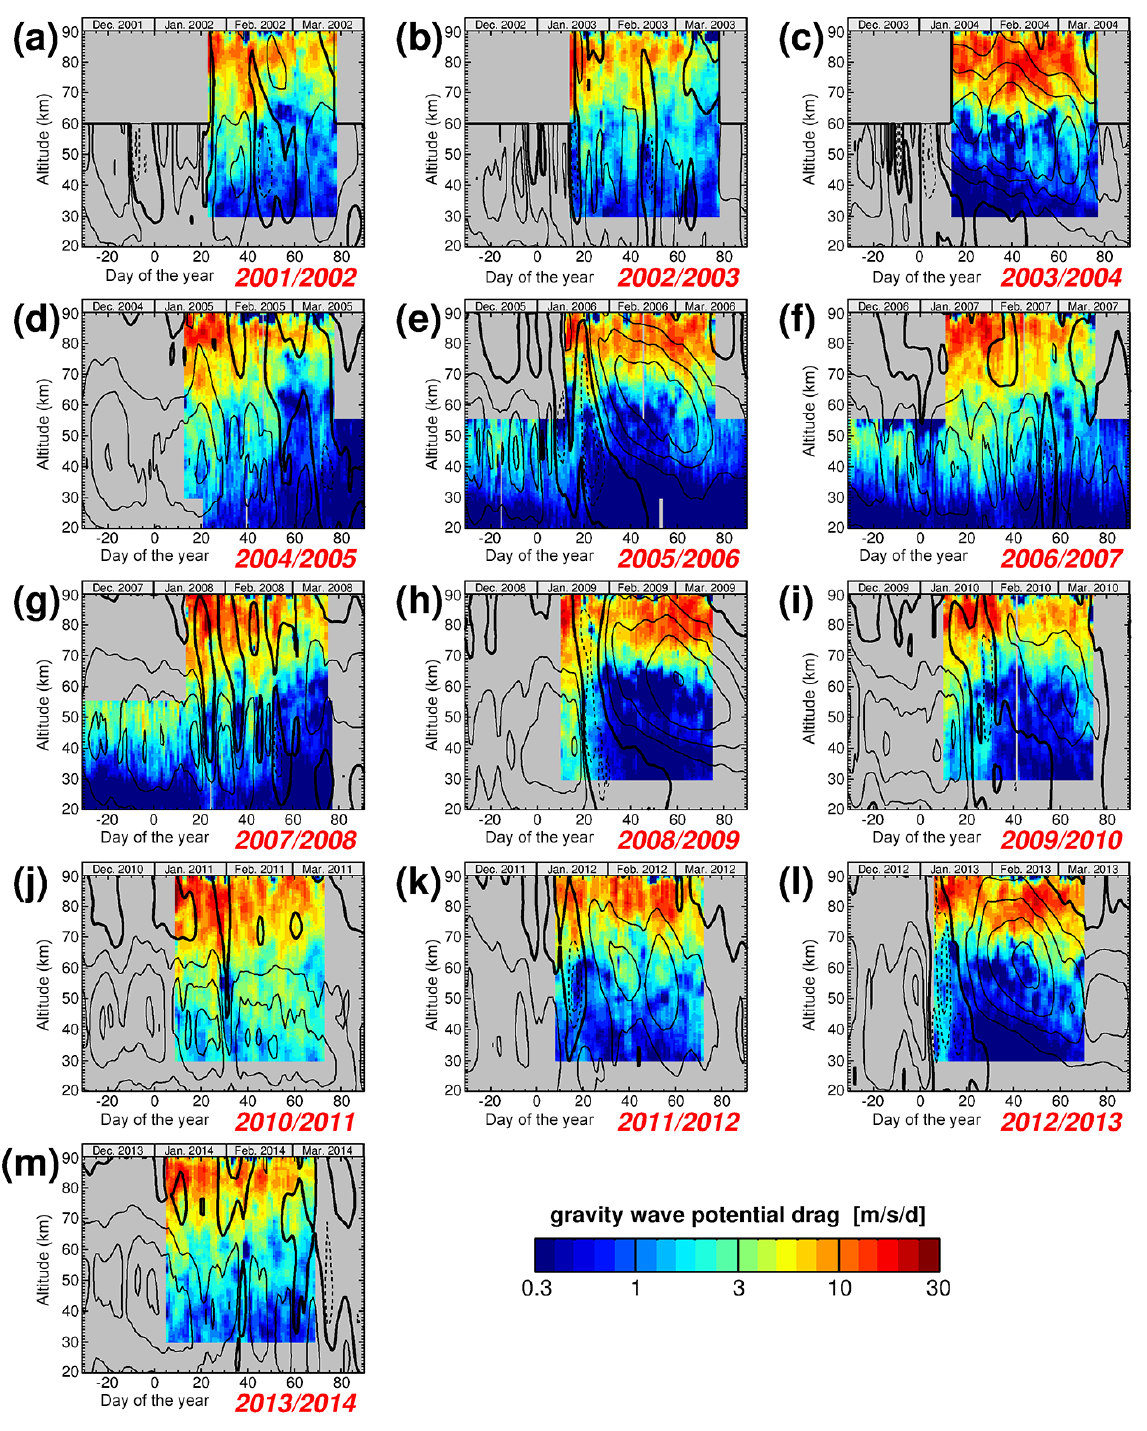
Figure 6. Same as in Fig. 3, but for gravity wave potential drag at 60–80 ◦ N. Potential drag is given in ms − 1 day − 1 on a logarithmic color scale. Like in Fig. 1, overplotted contour lines indicate zonal average zonal winds at 60–80 ◦ N in steps of 20ms − 1 .